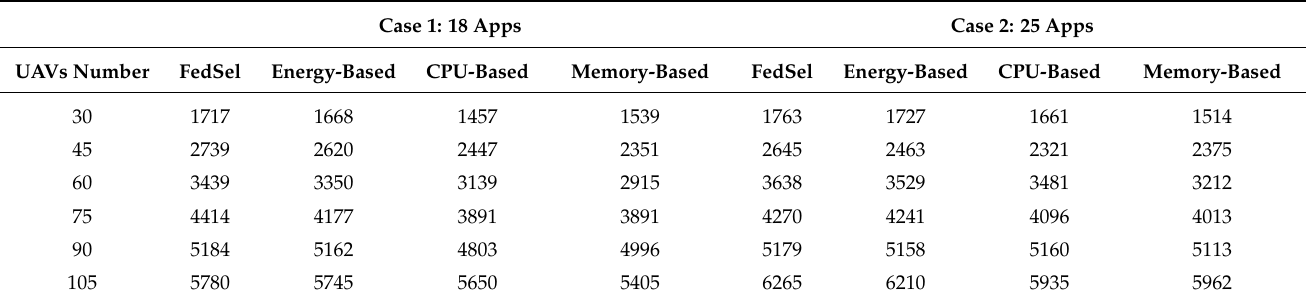
Table 4. Objective function numerical